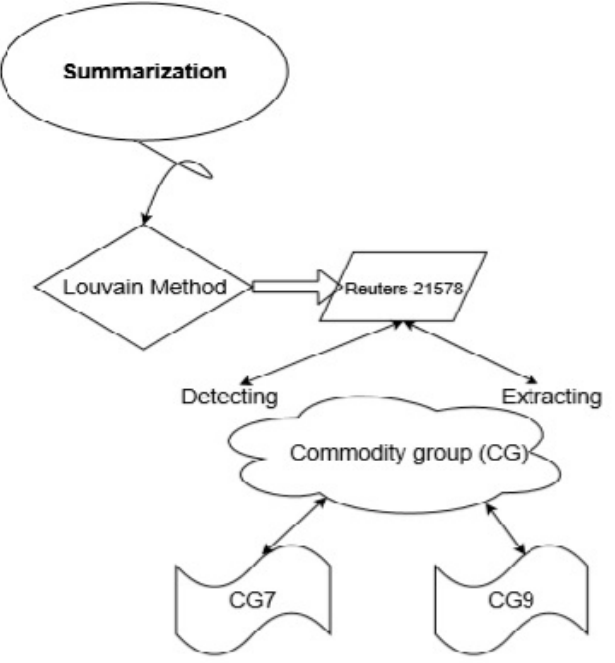
Figure 1. The workflow of the Louvain Method.